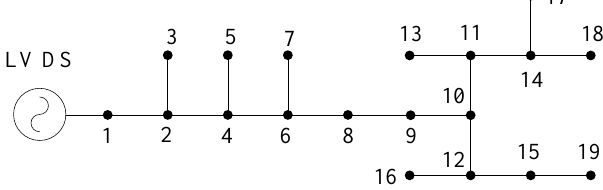
Figure A3. Configuration of the 19-node